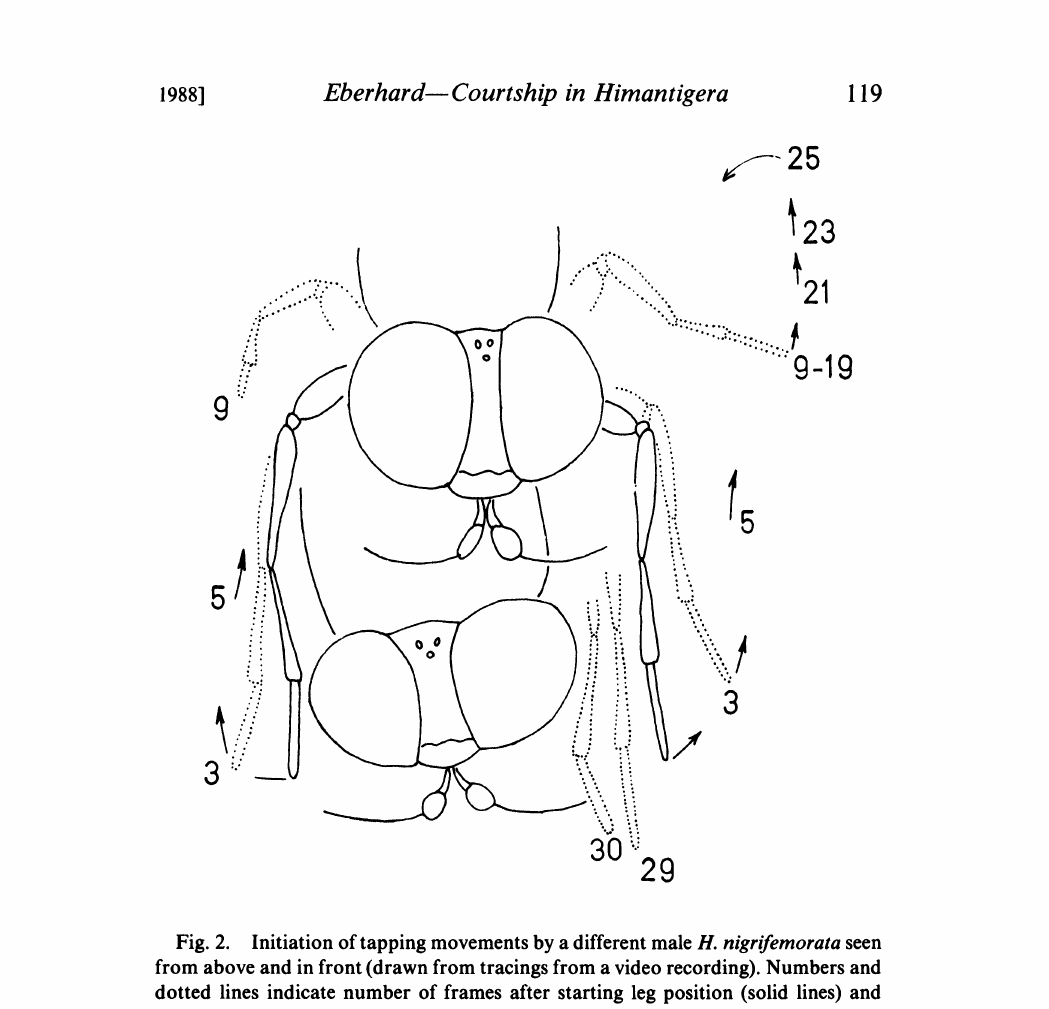
Fig. 2. Initiation of tapping movements by a different male H. nigrifemorata seen from above and in front (drawn from tracings from a video recording). Numbers and dotted lines indicate number of frames after starting leg position (solid lines) and positions of legs at these times. After both legs were raised simultaneously to point upward over the male’s head (frame 9), the left leg was held immobile (9-19) while the right leg swung back and down (not shown); then the left leg was swung back (21-25) and then down (25), then moved slightly to the side (30). It was not possible to determine from the videotape whether the tarsus contacted the female’s